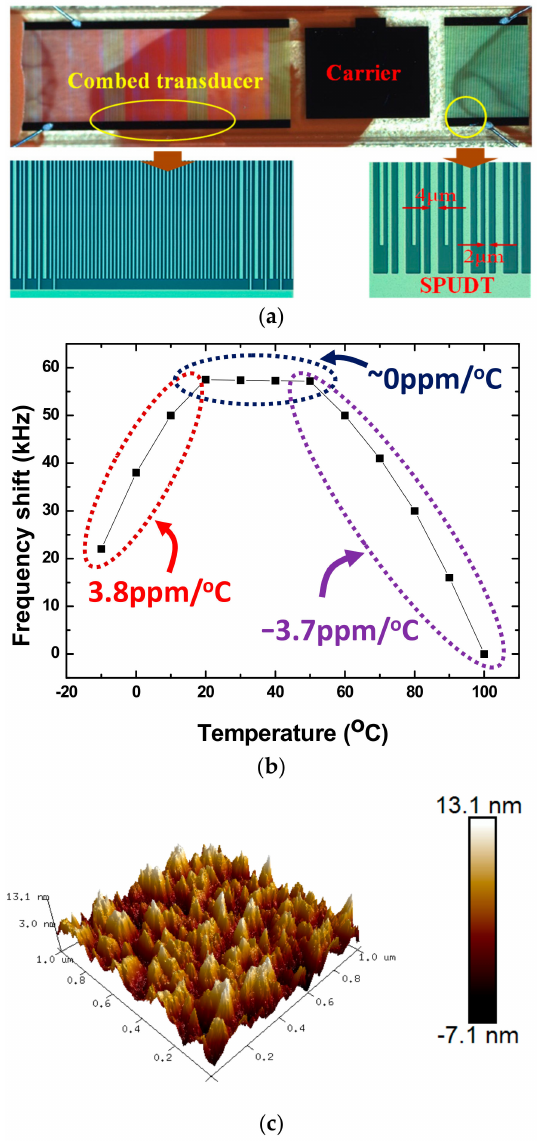
Figure 2. ( a ) The optical picture of the prepared SAW device for H 2 S sensing, ( b ) measured crossed temperature sensitivity of the proposed SAW device, and ( c ) the Atomic Force Microscop (AFM) picture of the TEA